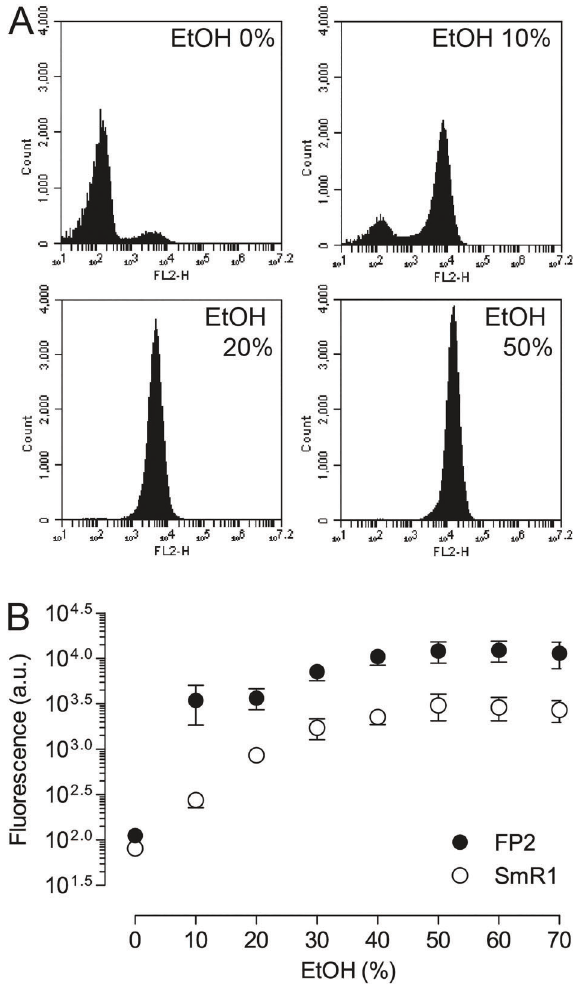
Figure 2. Optimization of ethanol (EtOH) percentage in TBAC buffer for cell permeabilization. Bacteria were grown at an OD 600 of 1.2, 0.1 mL was centrifuged (1 min at 13,400 g ), and resus- pended in 1 mL of TBAC buffer containing different percentages of EtOH (0 – 70%). After 5 min of EtOH exposure, cells were stained with Nile red (9.42 m M) during 5 min, centrifuged (1 min at 13,400 g ), and resuspended in TBAC buffer for analysis by fl ow cytometry. A , Histograms are representative of A. brasilense strain FP2 using different percentages of EtOH in TBAC buffer, as indi- cated. B , Fluorescence data (arbitrary units, a.u.) are reported as means ± SD of 3 independent experiments with H. seropedicae strain SmR1 and A. brasilense strain FP2, by using the median fl uorescence intensity values in the FL2-H